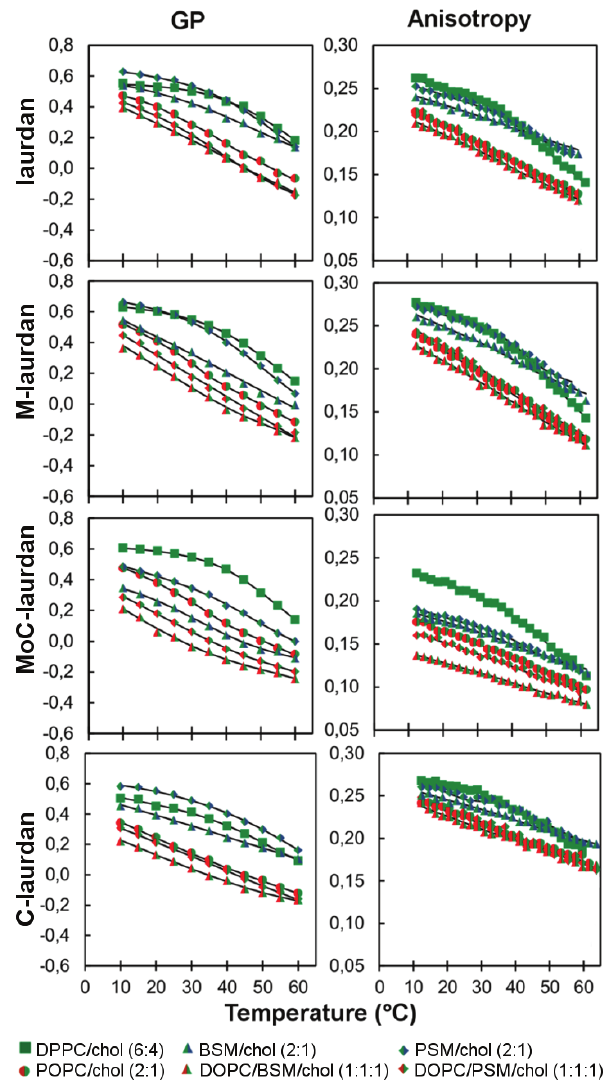
Figure 6. GP and anisotropy of laurdan, M-laurdan, MoC-laurdan and C-laurdan dyes in model membrane in Lo phase (green, blue/green and red/green color codes depicting liquid ordered and mixed phases). either BSM or PSM, and confirmed their results showing inter- mediary values for GP, compared to pure So and Ld phases. Our interpretation, however, differs from theirs. Indeed, we believe that the resulting emission spectrum and the corresponding GP values could simply correspond to a juxtaposition of Ld phases, enriched in DOPC, and Lo phases, enriched in sphingomyelin and choles- terol, (Figure 4 and Figure 6, Figure S5). Similar intermediary values were obtained in POPC/cholesterol (2:1) bilayers, in which Lo and Ld phases are known to coexist. In addition, intermediary values were also found for anisotropy. Furthermore, the interpre- tation that this mixture, DOPC/sphingomyelin/cholesterol (1:1:1) contains both Lo and Ld phases is in good agreement with previous publications 37